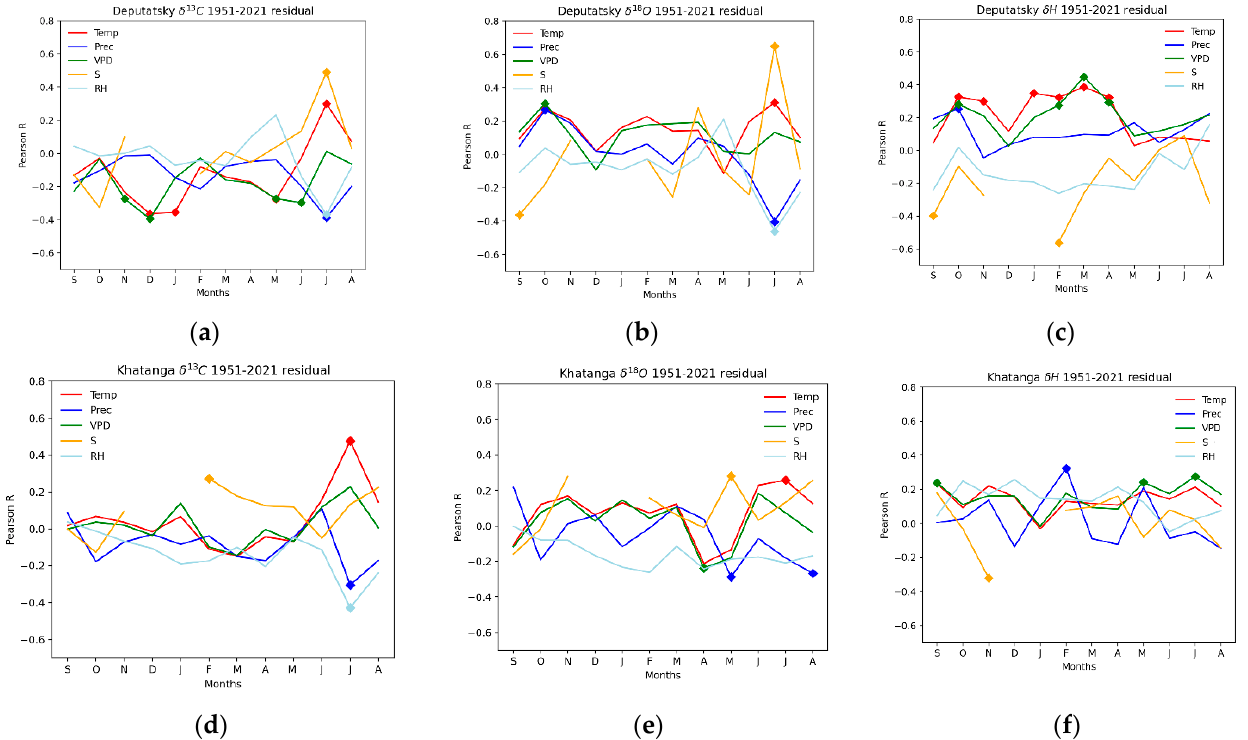
Figure 3. Pearson correlation coefficients calculated between stable carbon ( δ 13 C) ( a , d ), oxygen ( δ 18 O) ( b , e ) and hydrogen ( δ 2 H) ( c , f ) isotopes in tree-ring cellulose versus air temperature (Temp), precipitation (Prec), vapour pressure deficit (VPD), sunshine duration (S) and relative humidity (RH) calculated from September of the previous year to August the current one for the period from 1951 to 2020, based on data from the Deputatsky weather station for YAK ( a – c ) and from the Khatanga weather station for TAY ( d – f ). Significant values at p < 0.05 are marked as a rhombus.